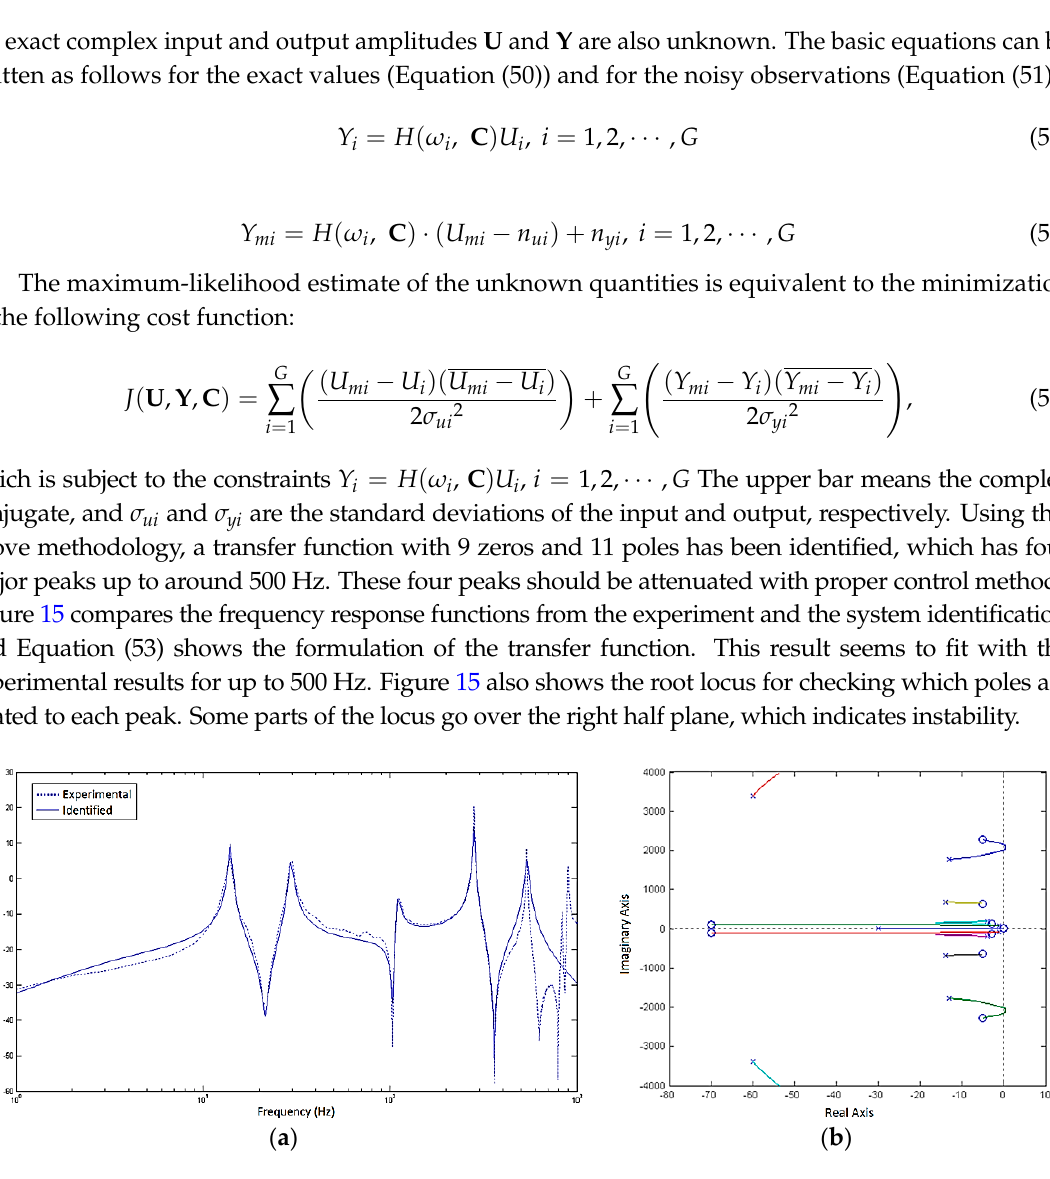
Figure 15. Comparison of: ( a ) frequency response functions; and ( b ) root locus.